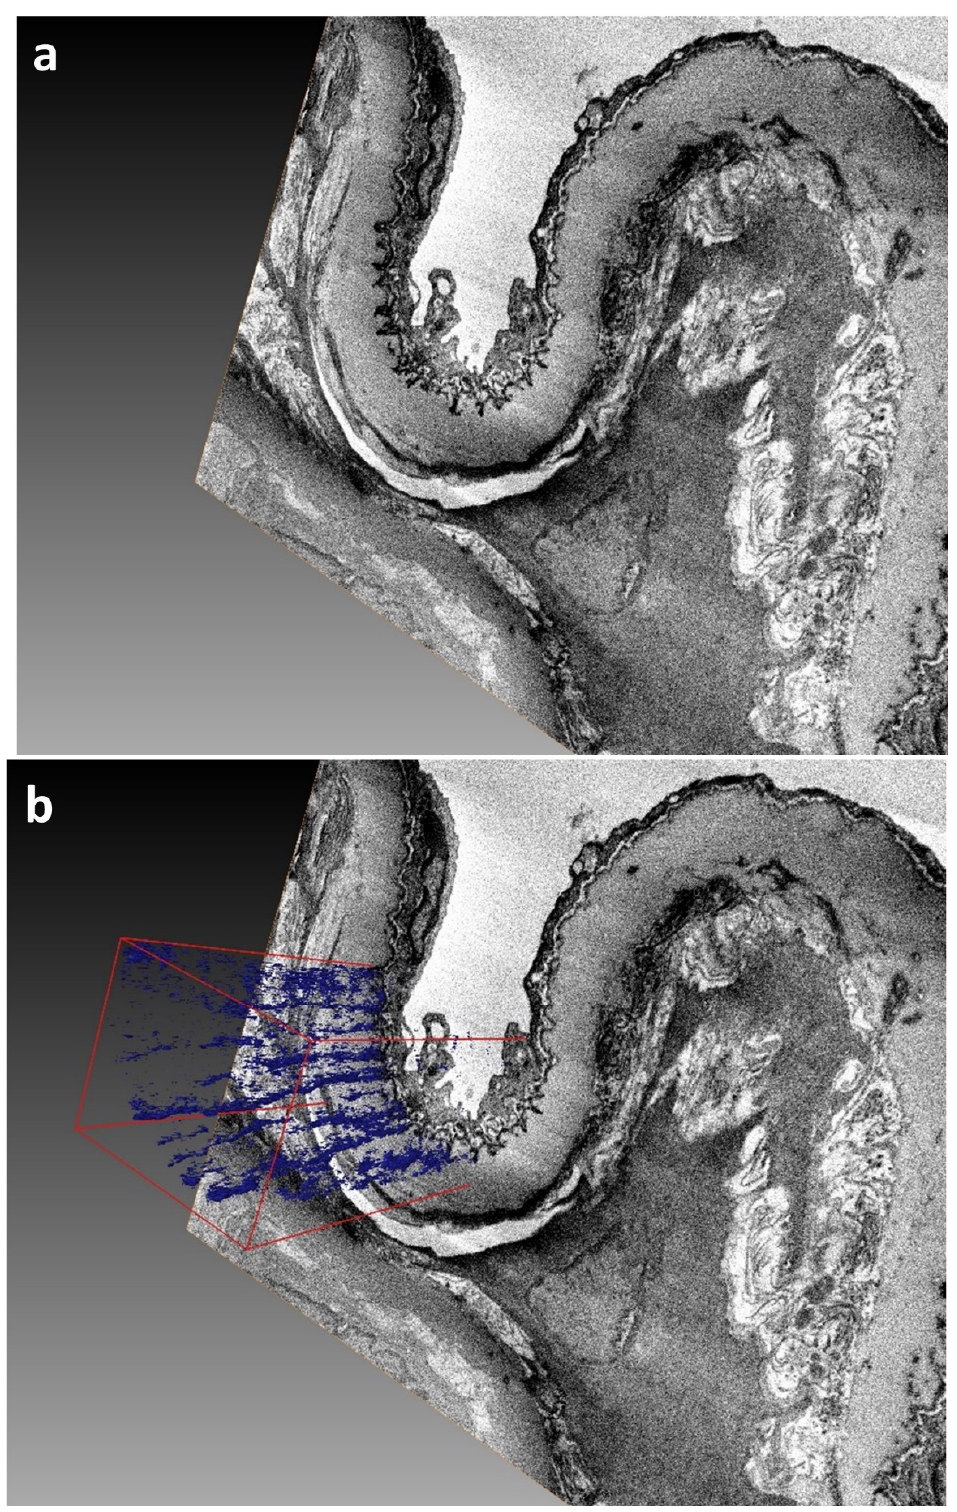
Figure 4 : SBF SEM image data volume (40 × 25 × 25 microns) from a mouse aorta. The aorta is the main artery of the mammalian heart and in cross section comprises of numerous concentric layers of alternating collagenous ECM and elastin sheets, which surround a central lumen. ( a ) demonstrates an SBF SEM-acquired image of the aorta prior to 3D reconstruction. ( b ) reveals the arrangement of nanoscopic fibrillin micro-fibrils within one elastin sheet shown in blue using iso-surface